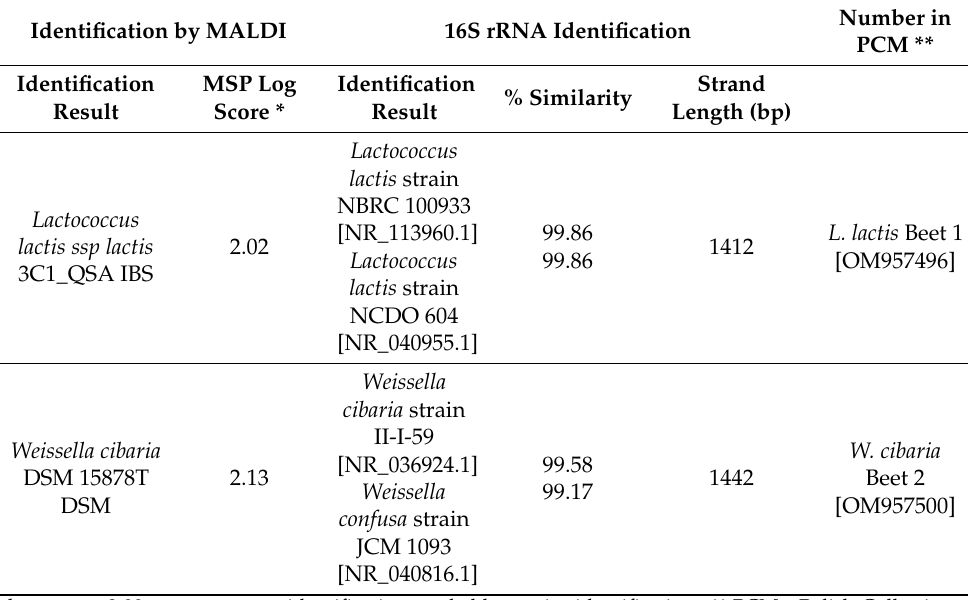
Table 3. Comparison of identification results between the MALDI and 16S rRNA techniques. Identification by